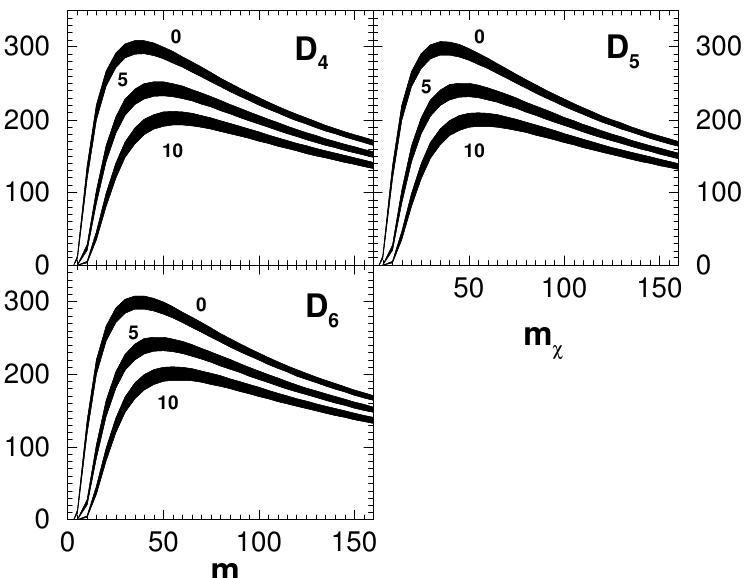
Figure 11. Nuclear structure coefficients plotted as a function of the WIMP mass m χ in GeV for 40 Ar. The graphs are plotted for three values of the detector threshold Q thr namely Q thr = 0,5,10 keV. The thickness of the graphs for each value of Q thr represents the annual modulation.